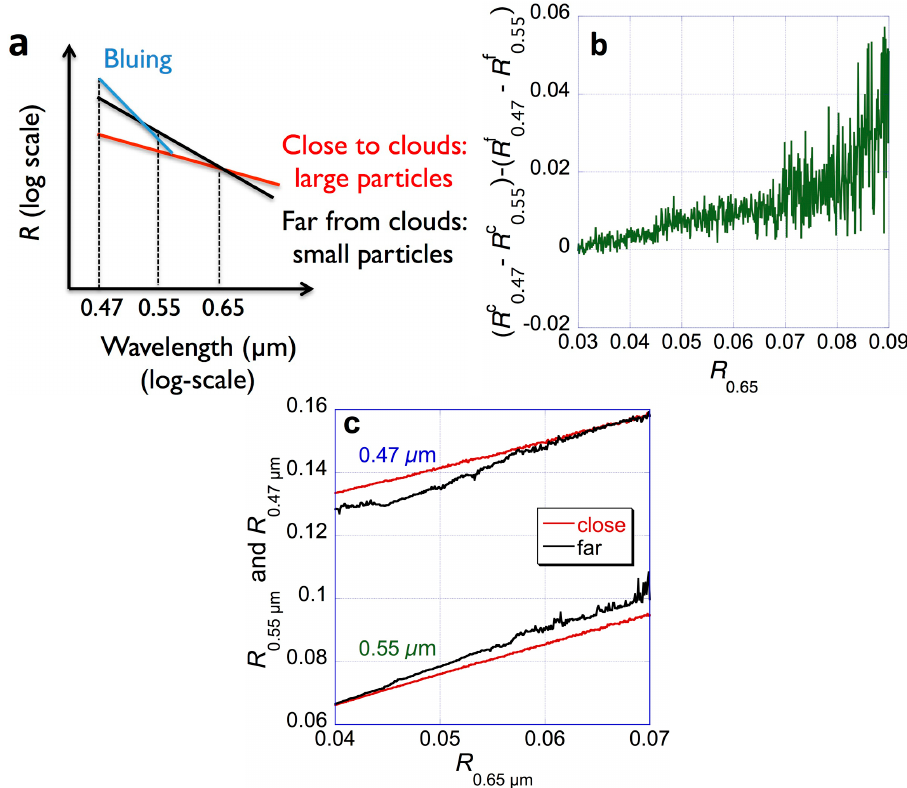
Fig. 2. (a) Schematic graph illustrating the average spectral dependence of clear sky solar reflectance close to clouds and far from clouds, given a reflectance at 0.65µm. (b) Difference between the steepness of observed mean spectral dependence ( R 0 . 47 − R 0 . 55 ) close to clouds (superscript “c”) and far from clouds (superscript “f”), as a function of R 0 . 65 . (c) Mean 0.47 and 0.55µm reflectances as a function of 0.65µm reflectance, close to clouds (red) and far from clouds (black). The close and far categories include areas that are less than or more than 5km away from the nearest cloud, respectively. R 0 . 47 , R 0 . 55 , and R 0 . 65 are the mean reflectances observed by MODIS at 0.47, 0.55, and 0.65µm